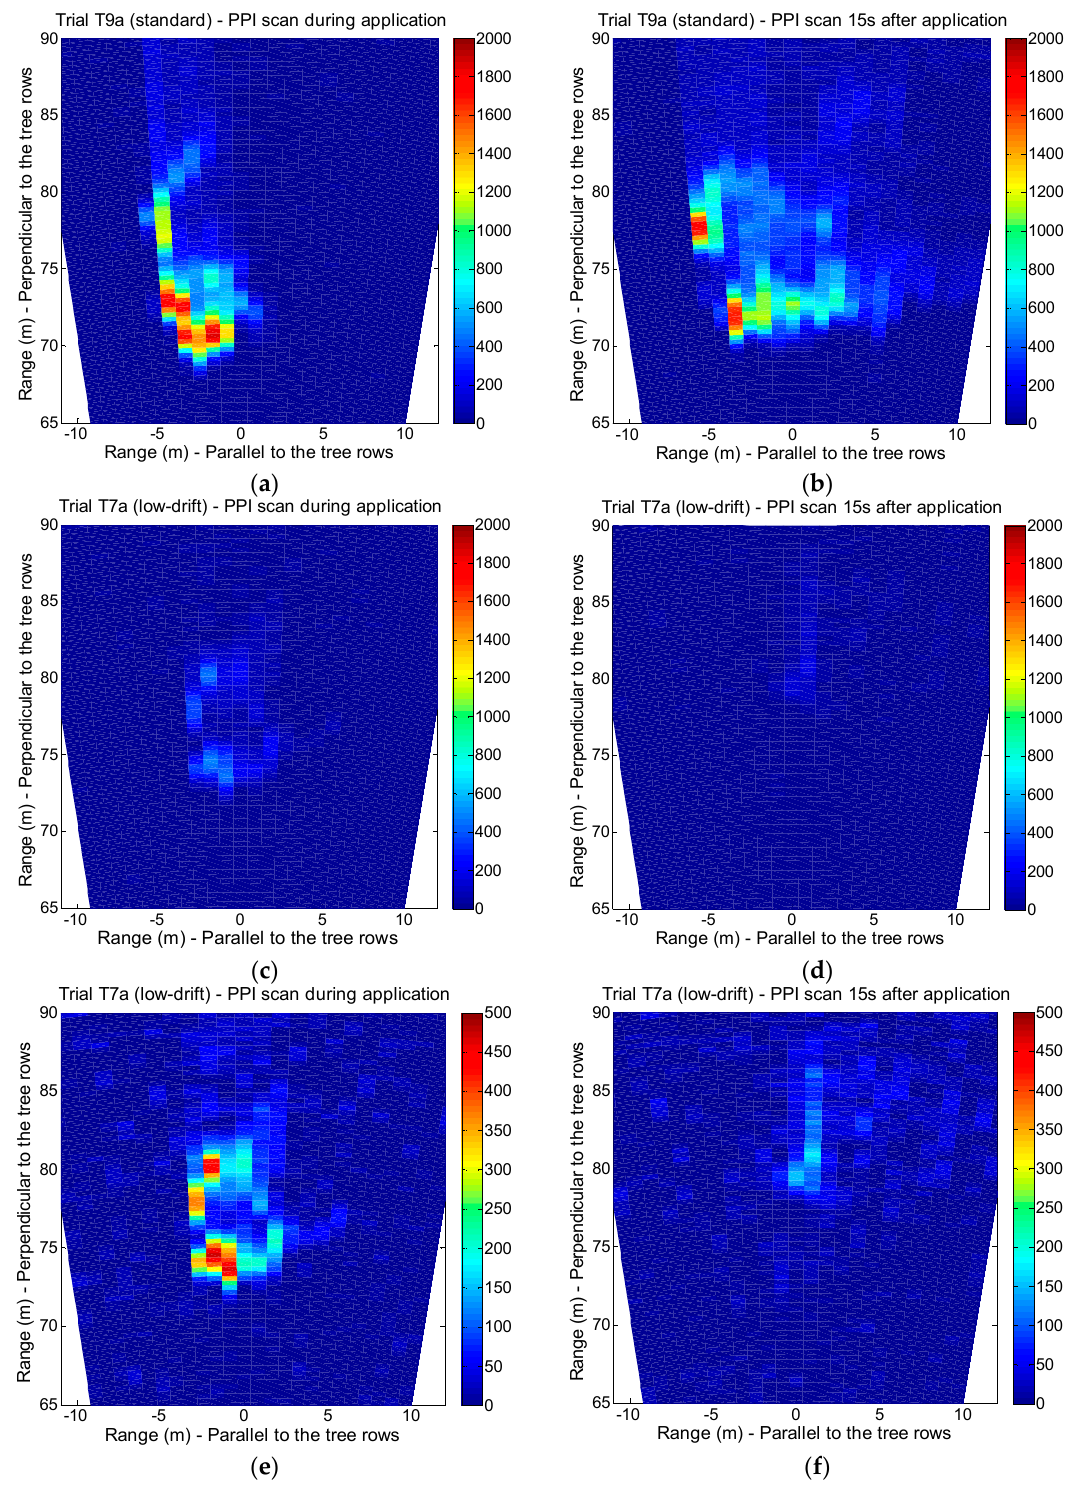
Figure 6. PPI lidar scans of several spray plumes. ( a ) Test T9a (standard nozzles), during the application; ( b ) Test T9a, 15 s after the application; ( c ) Test T7a (low-drift nozzles), during the application; ( d ) Test T7a, 15 s after the application; ( e ) Test T7a, during the application; ( f ) Test T7a, 15 s after the application. Colorbar represents range-corrected backscattered signal (arbitrary units: a.u.). Signal range in ( a – d ) is 0–2000 a.u.; in ( e , f ) is 0–500 a.u.